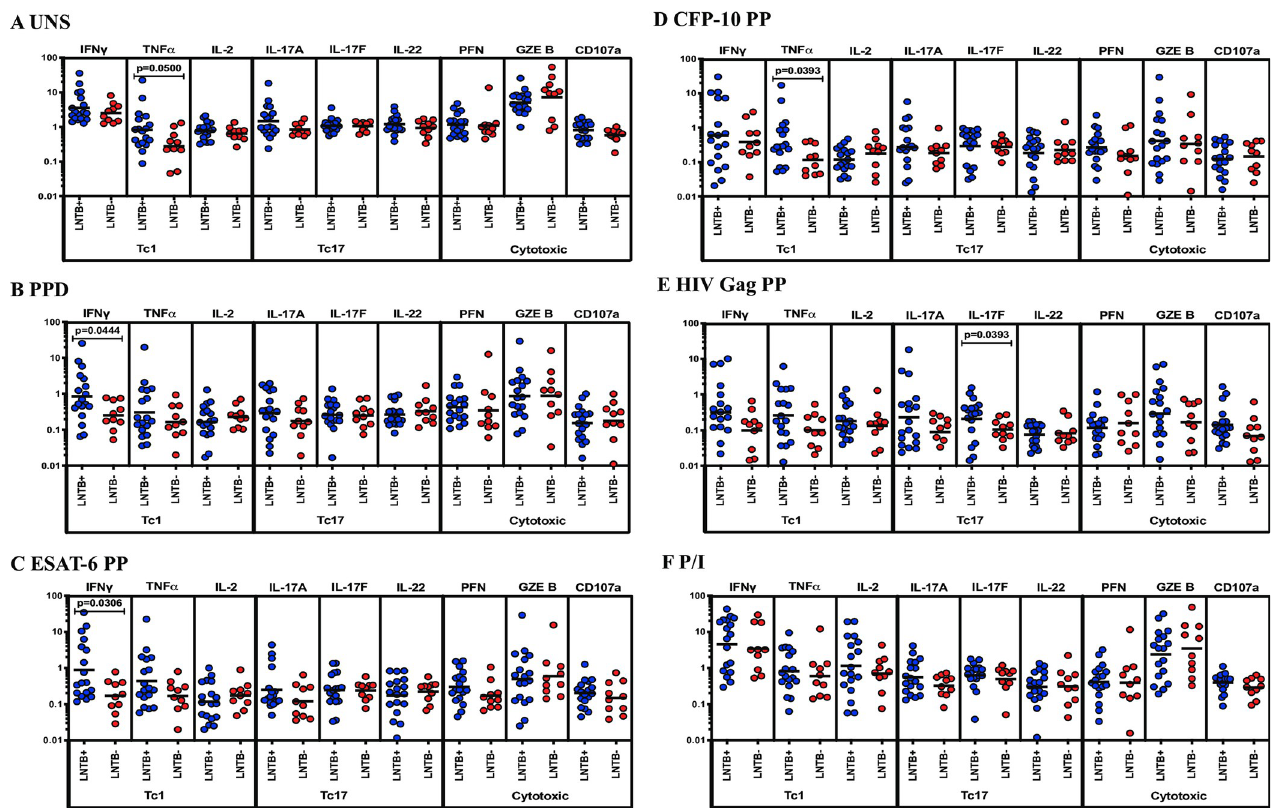
Fig 2. LNTB+ individuals are associated with enhanced antigen-induced frequencies of CD8 + T cells expressing Tc1 (IFN γ , TNF α ) cytokines. LN cells from LNTB+ (n = 18) and LNTB- (n = 10) individuals were either unstimulated (UNS) or stimulated with mycobacterial, HIV Gag PP and positive (P/I) control antigens for 18 hours. LN cells were harvested, stained and analyzed using multicolour flow cytometry. (A) UNS (B-D) Mtb antigen (E) HIV Gag PP and (F) P/I antigen-stimulated CD8 + T cell expressing frequencies of Tc1 (IFN γ , TNF α , IL-2), Tc17 (IL-17A, IL-17F, IL-22) cytokines and cytotoxic (PFN, GZE B, CD107a) markers were illustrated. The geometric mean was shown using a bar and the Mann-Whitney U test was performed to calculate the p values and p < 0.05 is denoted as statistically significant. For each individual, we have given the values as net frequencies and they were obtained by deducting the unstimulated frequencies from the antigen-stimulated